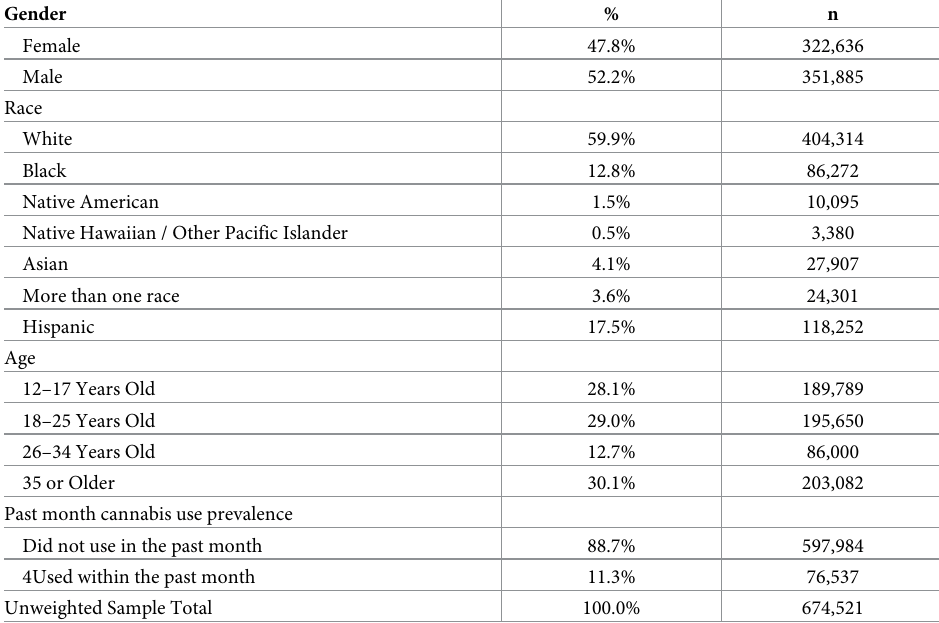
Table 1. Characteristics of the U.S. population under study from the U.S. National Surveys on Drug Use and Health.